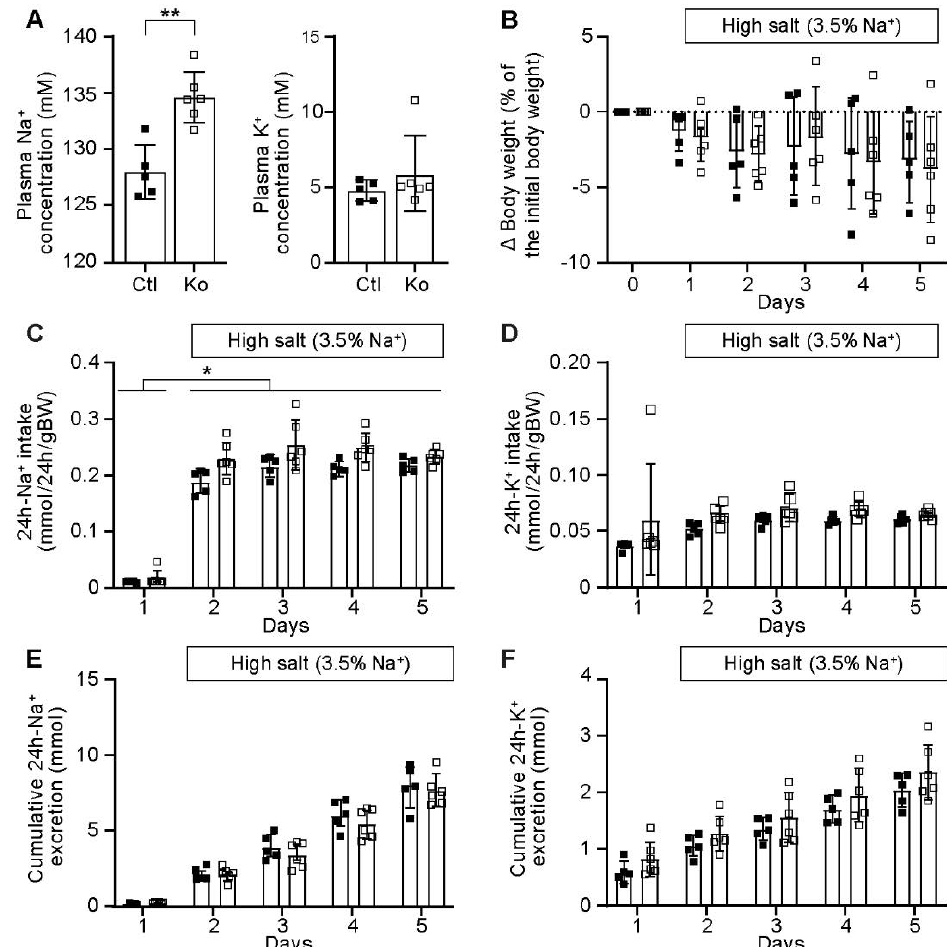
Figure 2. Prss8 PaxLC1 (knockout) mice showed increased plasma Na + concentration under high Na + diet. ( A ) Plasma Na + and K + (mM) concentrations in control (n = 5, left panel, black) and knockout (Ko, n = 6, right panel, white square) mice. ( B ) Body weight changes (expressed as percent of initial body weight; control, n = 5; Ko, n = 6), ( C ) 24 h Na + and ( D ) K + intake and ( E ) 24 h cumulative Na + and ( F ) K + (mmol/24 h/gBW) excretion; control, n = 4-5; Ko, n = 5-6). Results are presented as mean ± SD. ( A ) was analyzed by unpaired two-tailed t test, ( B – F ) by a multiple t -test. p values < 0.05 were considered statistically significant. * p < 0.05, ** p < 0.01.